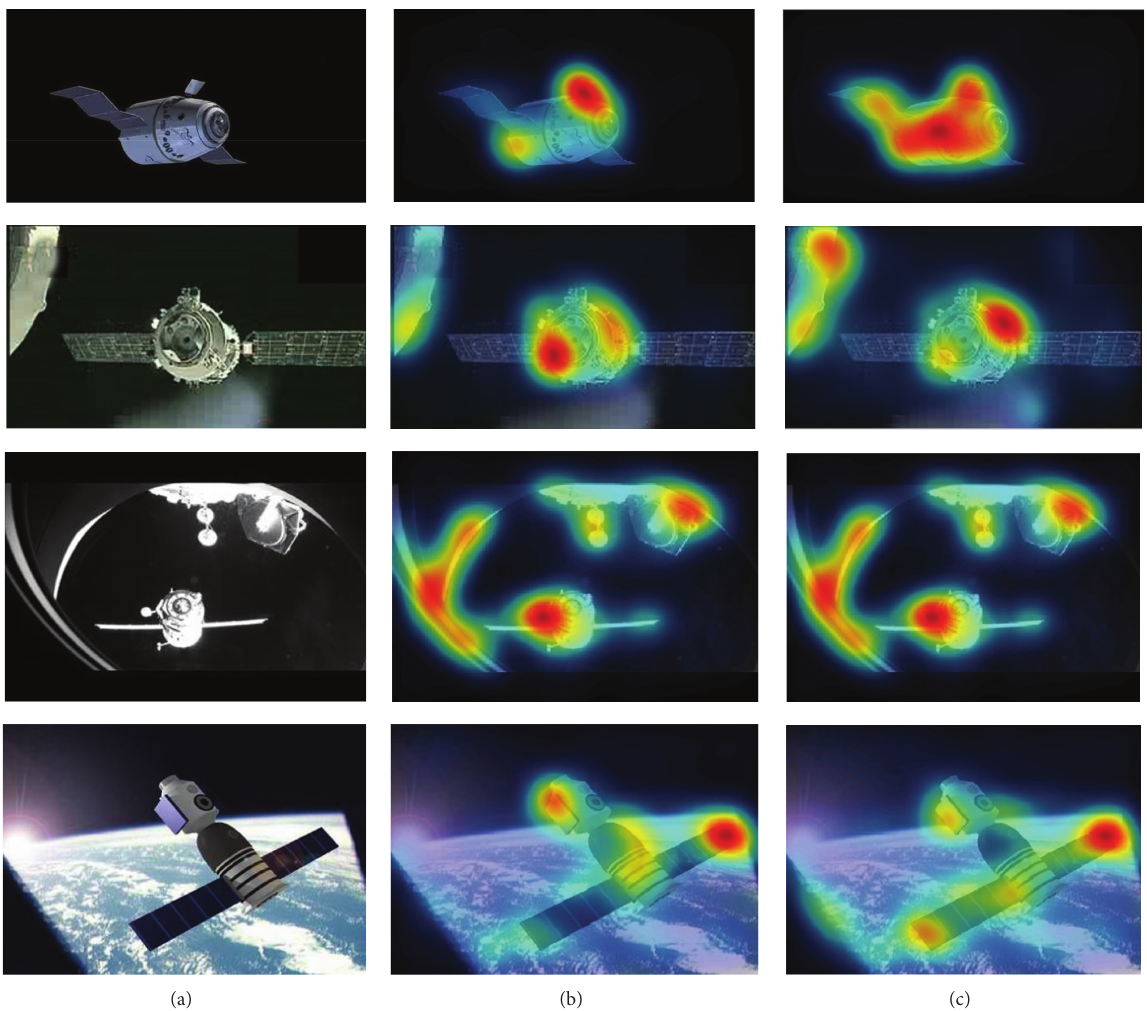
Figure 3: Markov random field representation in the perceptual spatial-space generation model. (a) Original frame and (b)–(c) initial and global smoothing